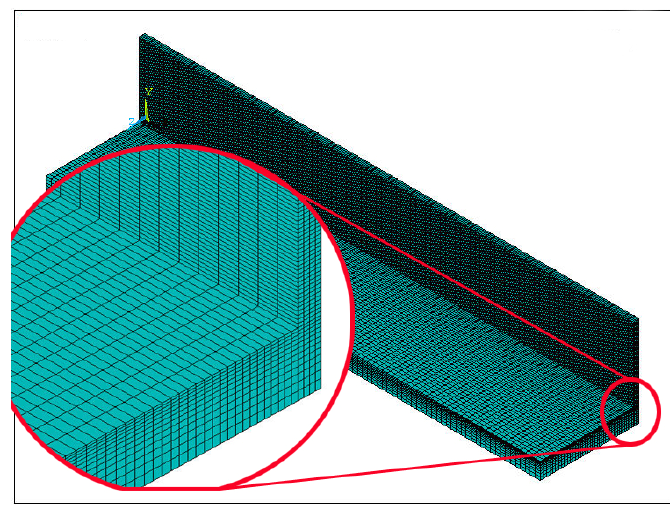
Figure 2. Finite element mesh generation and local magnification.